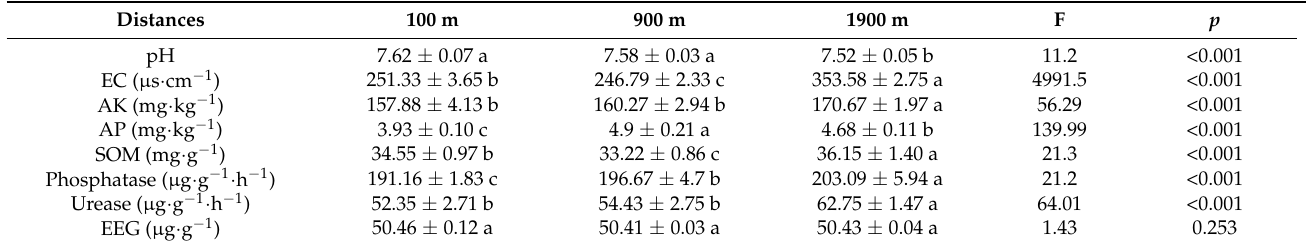
Table 1. Changes of soil parameters at areas with different distances to the